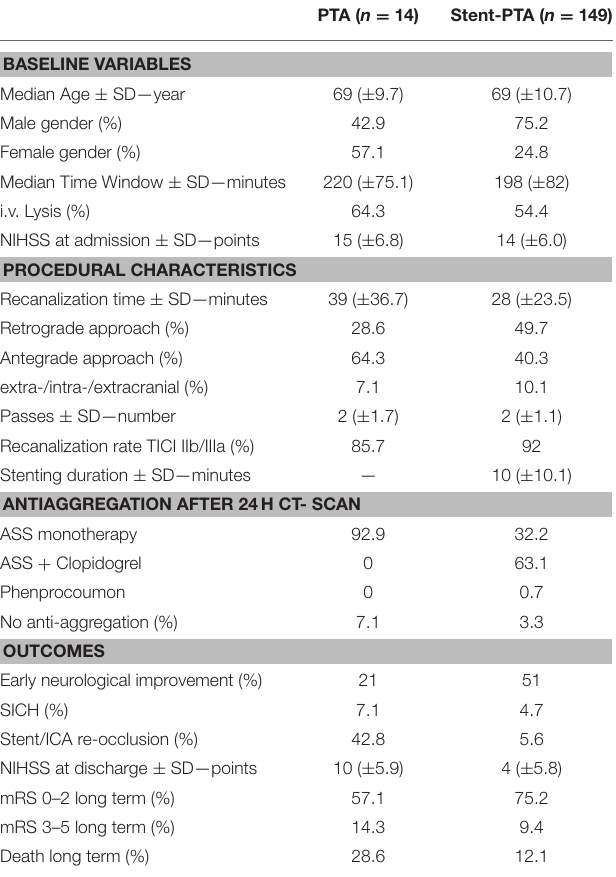
TABLE 1 | Baseline, treatment and outcome variables in the PTA only and stent group.